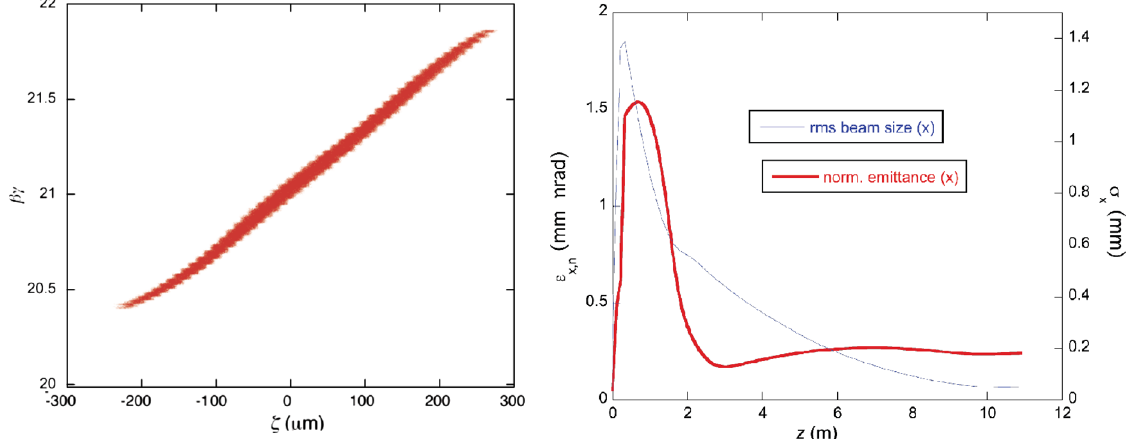
FIG. 4. (left) Longitudinal phase space for 125 pC beam distribution shown in Fig. 3, after 250 MV = m rf photoinjector. (right) Associated transverse rms beam envelope and normalized emittance